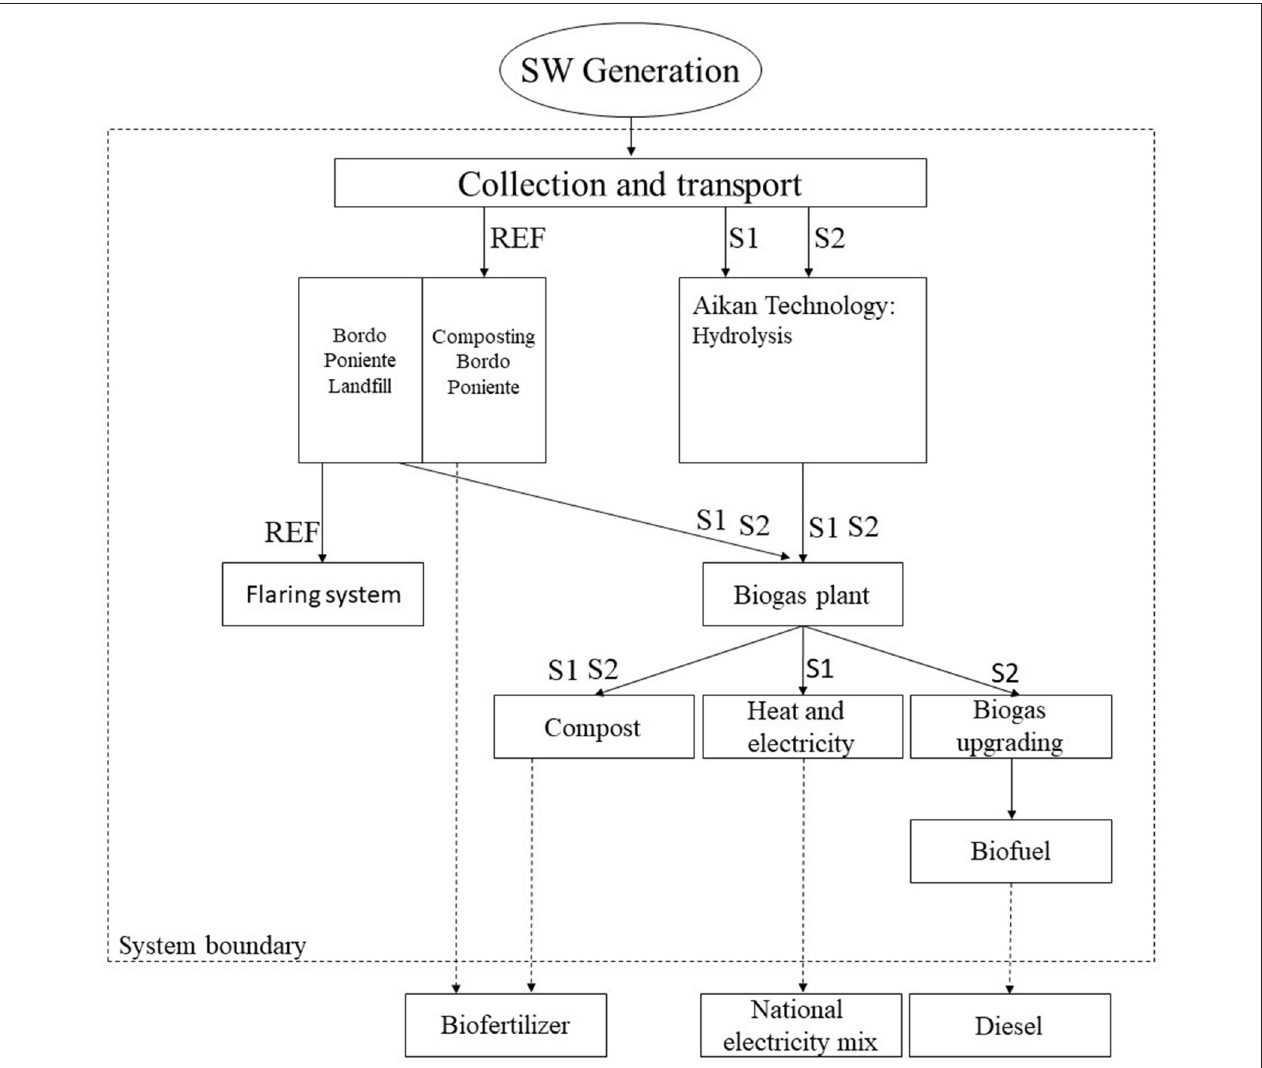
FIGURE 1 | System boundaries. REF represents the reference scenario with compost production without biogas recovery; S1 represents biogas recovery and composting through Aikan Technology for electricity and heat providing; and S2 represents biogas recovery and composting through Aikan Technology for biofuel production for the transport sector. While in S1 the electricity produced is transferred to the national grid, and thus avoids the production and use of non-renewable energy, in S2 the production of biofuel replaces (in part) the use of diesel and thus reduce the utilization of fossil fuel in the transport